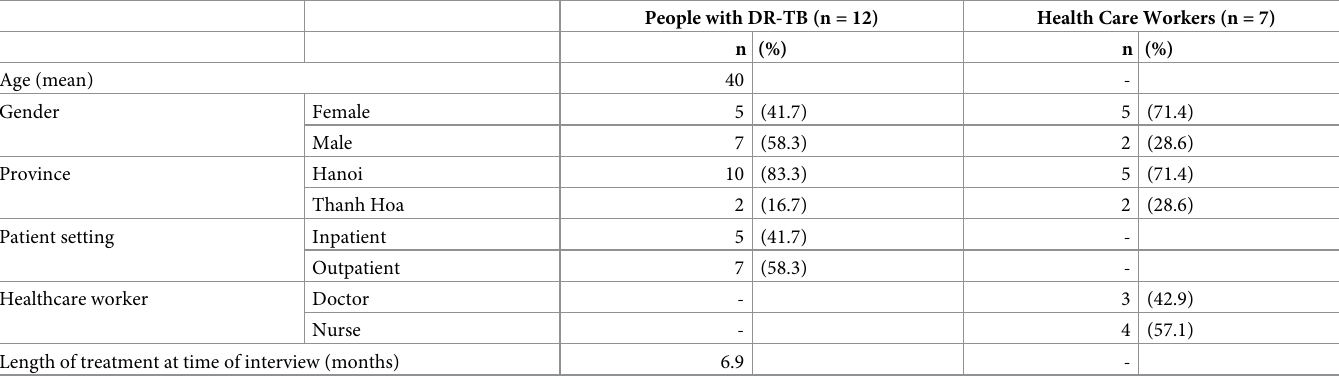
Table 1. Sociodemographic information of the study